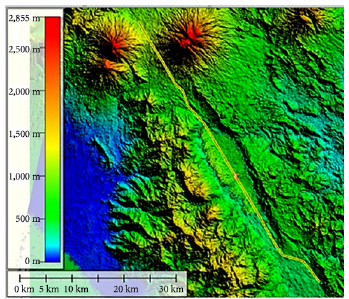
Figure 15. The latest DTM and Semangko fault line